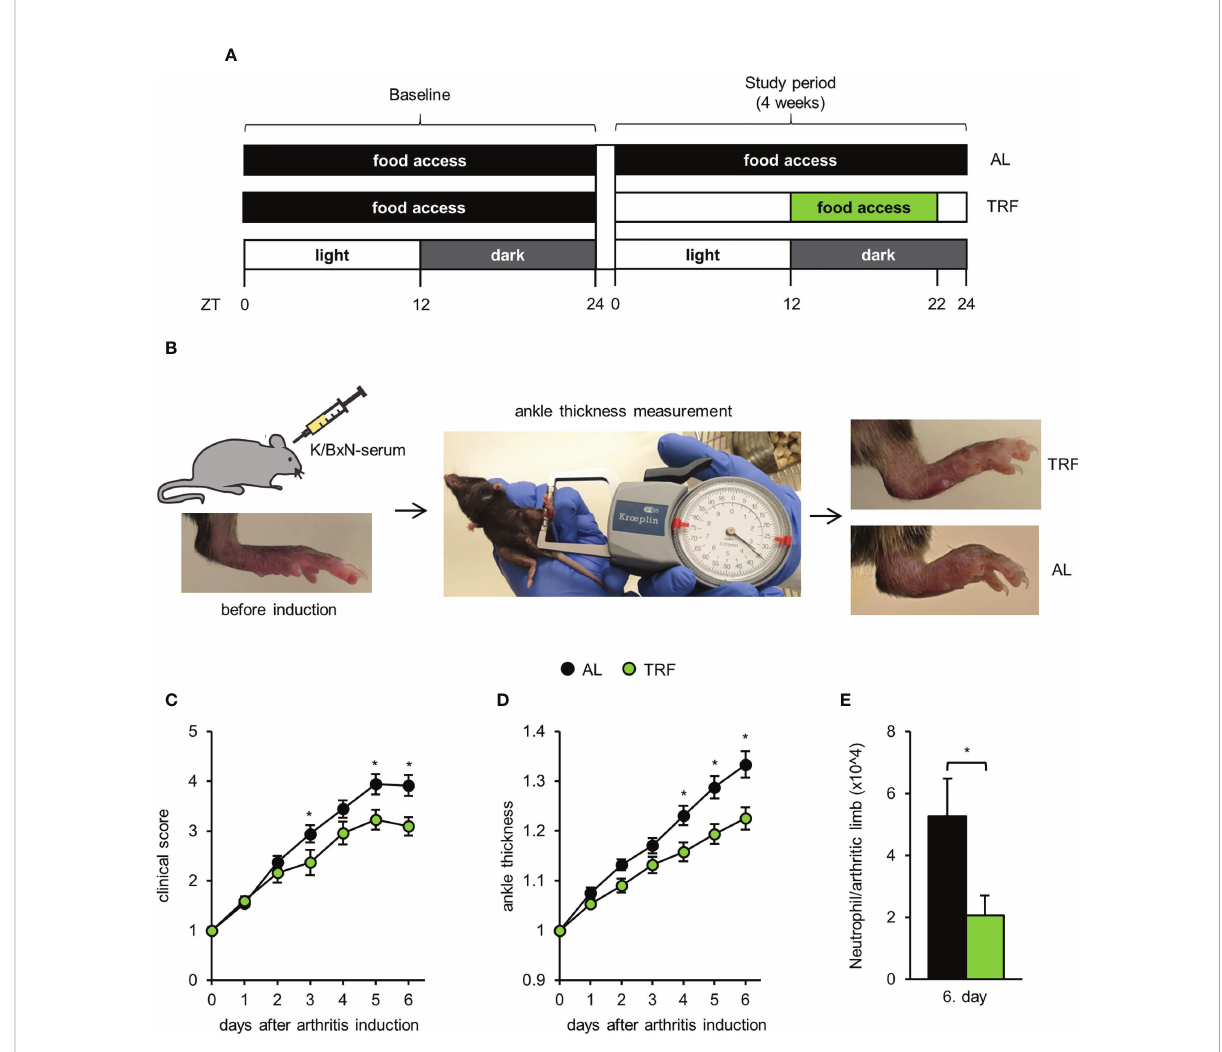
FIGURE 1 Time restricted feeding attenuates symptoms of autoin fl ammatory arthritis. (A) Schematic outline of the feeding regimens. (B) Short outline of the experimental setup and representative images of hind limbs of TRF and AL animals on the 6 th day after arthritis induction. For further details, see Materials and Methods. Mice were injected with K/BxN arthritic serum i.p. on day 0. Arthritis development was followed by clinical scoring of the limbs (C) and ankle-thickness measurement (D) . Data were normalized to values obtained on day 0 (mean ± SEM, n = 25 (AL) and n = 23 (TRF), repeated measures ANOVA, clinical score: group effect p = 0.053, group*day effect p = 0.0001, ankle-thickness: group effect p = 0.0056, group*day effect p = 0.0003, post-hoc Fisher test, * p < 0.05) (E) Neutrophil counts in the arthritic hind limbs of mice (mean + SEM, n = 7 (AL), n = 7 (TRF) mice, two-sample t-test, * p <